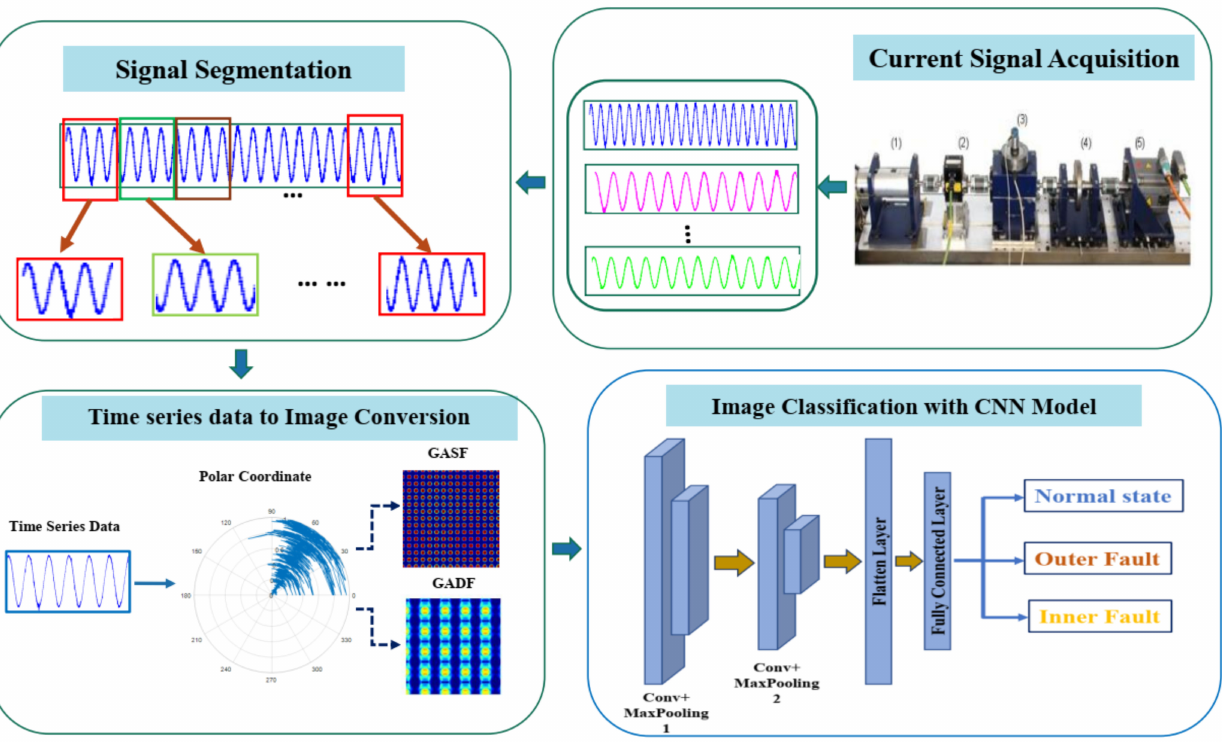
Figure 6. The workflow of the proposed